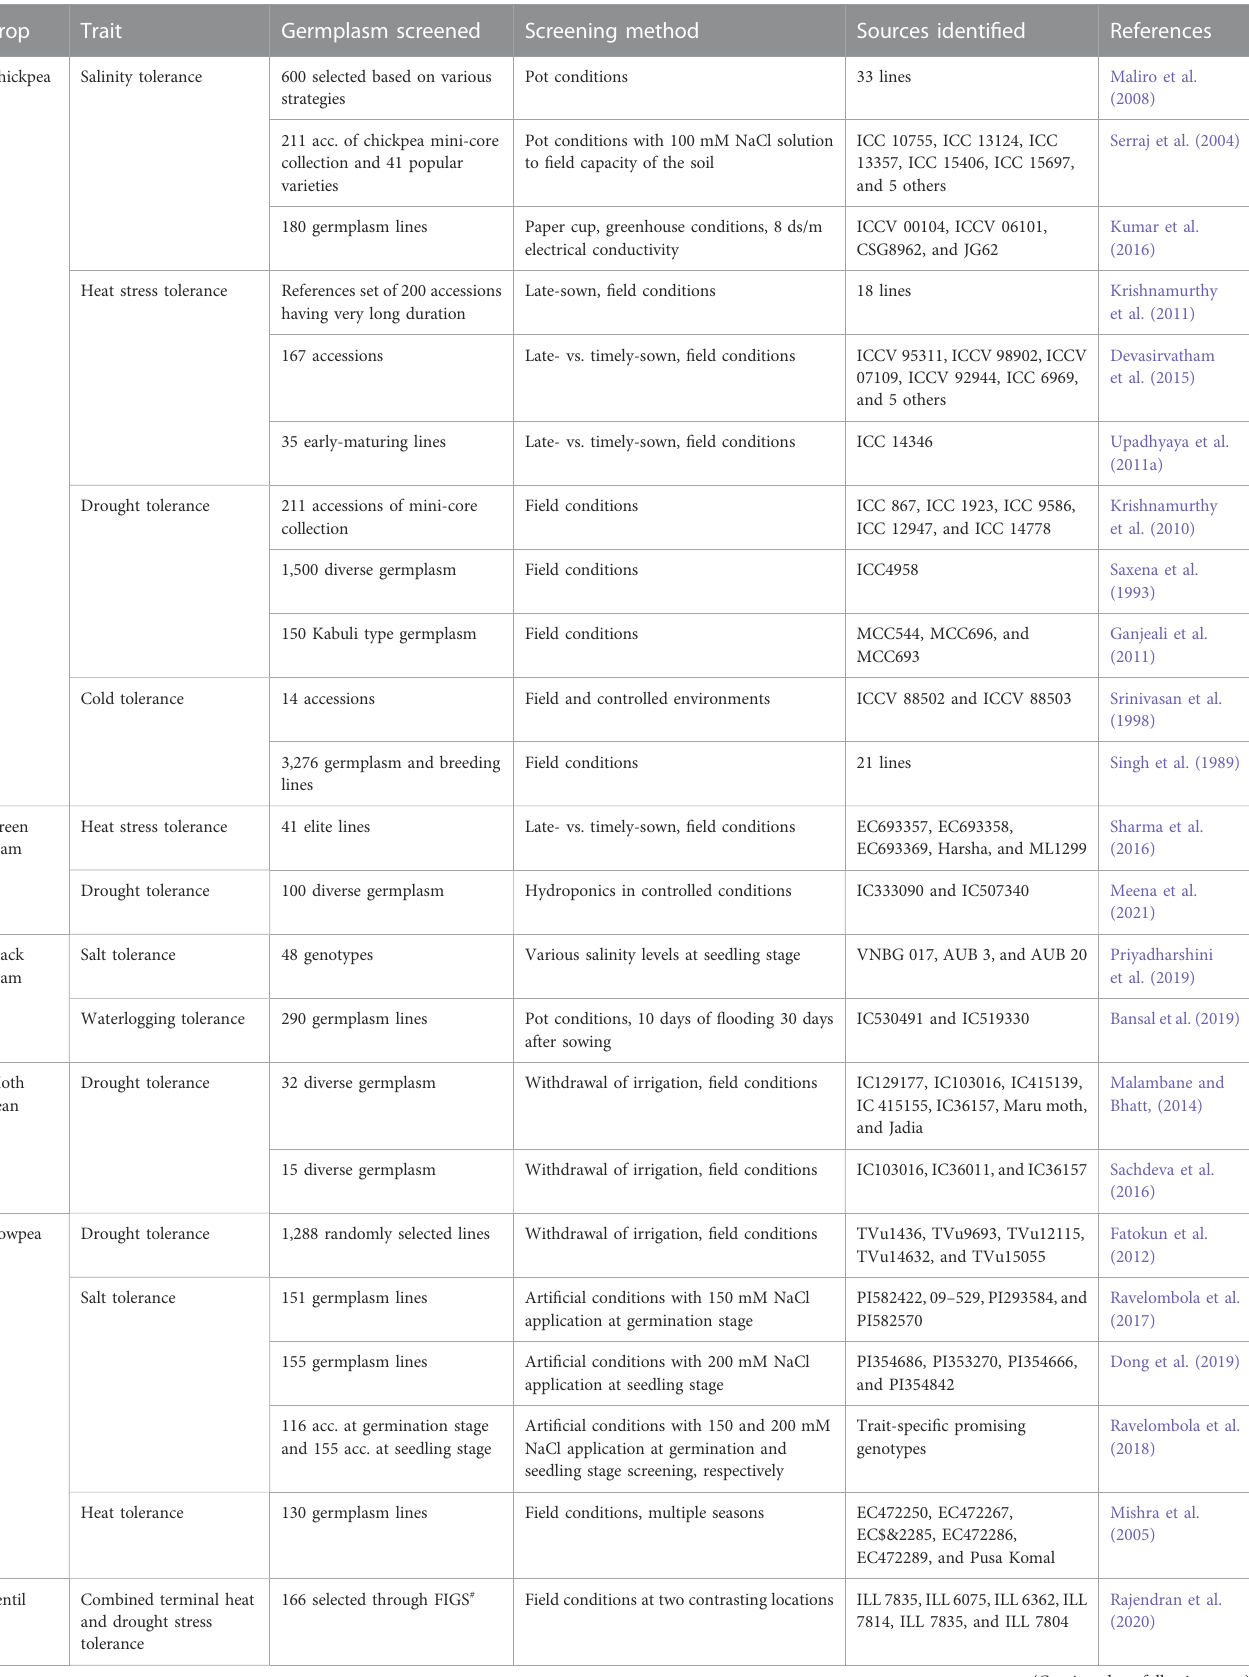
TABLE 5 List of important resistance sources identi fi ed for various important abiotic stresses in grain legume